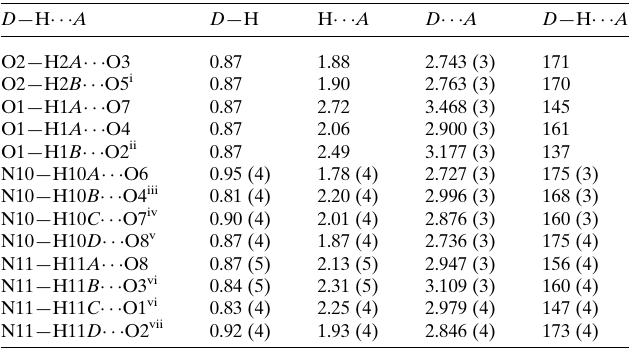
Table 1 Hydrogen-bond geometry (A˚ , (cid:5) ).